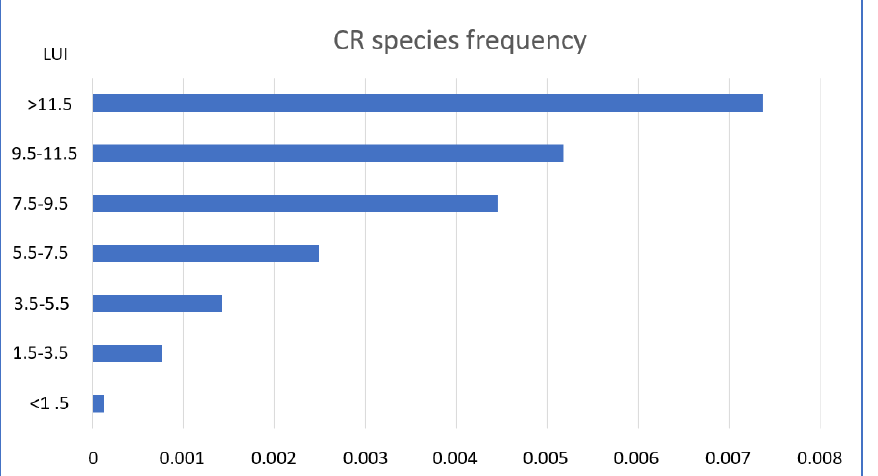
Figure 11. The distribution of known localities for critically endangered (CR) species in Norway for LUI index classes calculated as frequencies relative to the area.